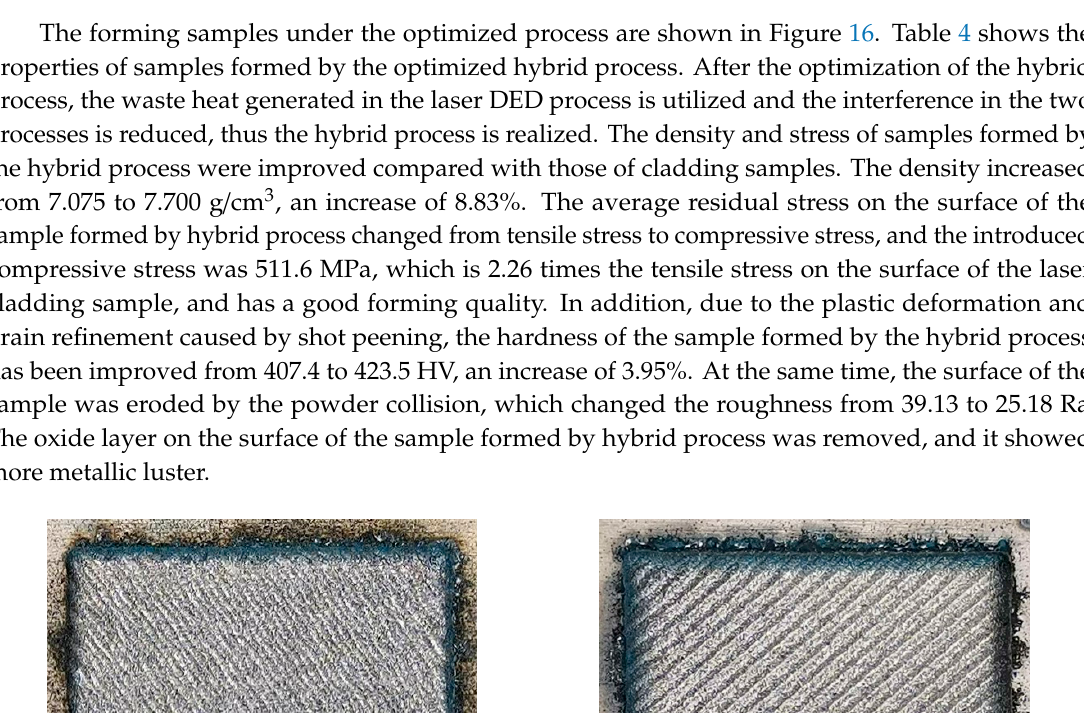
Table 4. The properties of the samples.